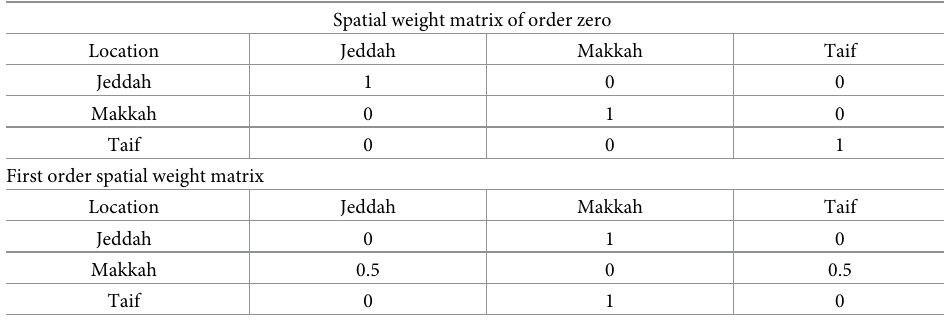
Table 3. Spatial weight matrix of order and one.